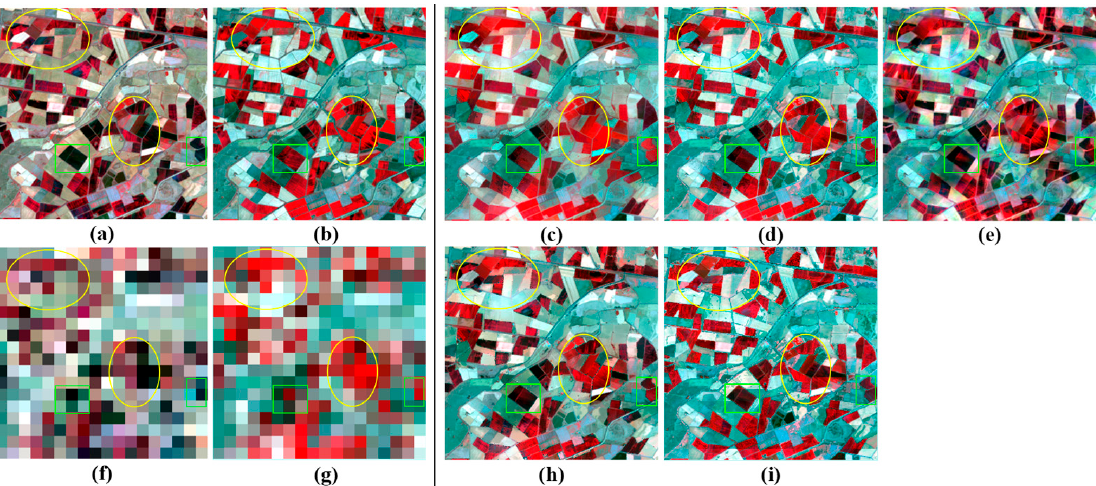
Figure 5. Zoomed-in area (green rectangle area in HR 0 of Figure 3a) of Landsat and MODIS image pairs at base date t1 ( a and f ) and prediction date t2 ( b and g ), as well as the simulated Landsat-like images predicted by Fit-FC ( c ), FSDAF ( d ), one-pair learning ( e ), STARFM ( h ) and UBDF ( i ).